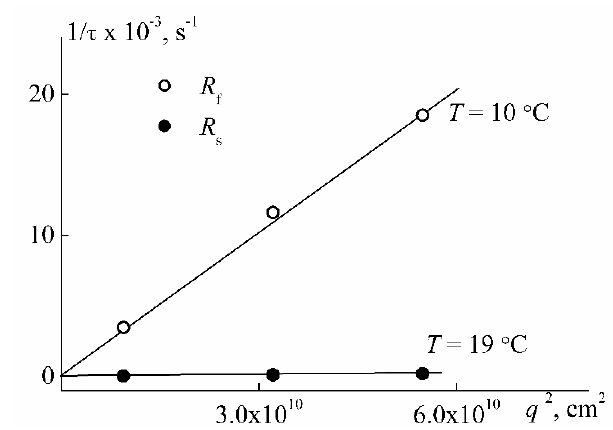
Figure 8. Dependencies of inverse relaxation times on the squared scattering wave vector for PEI-1 in water at 10 °С and 19 °С at c = 0.0374 g cm –3 .